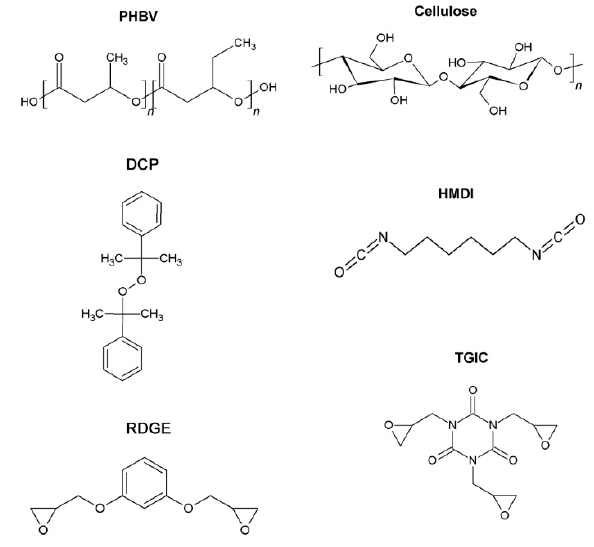
Figure 1. Chemical structures of polyhydroxylbutyrate (PHB), cellulose, and the reactive agents.